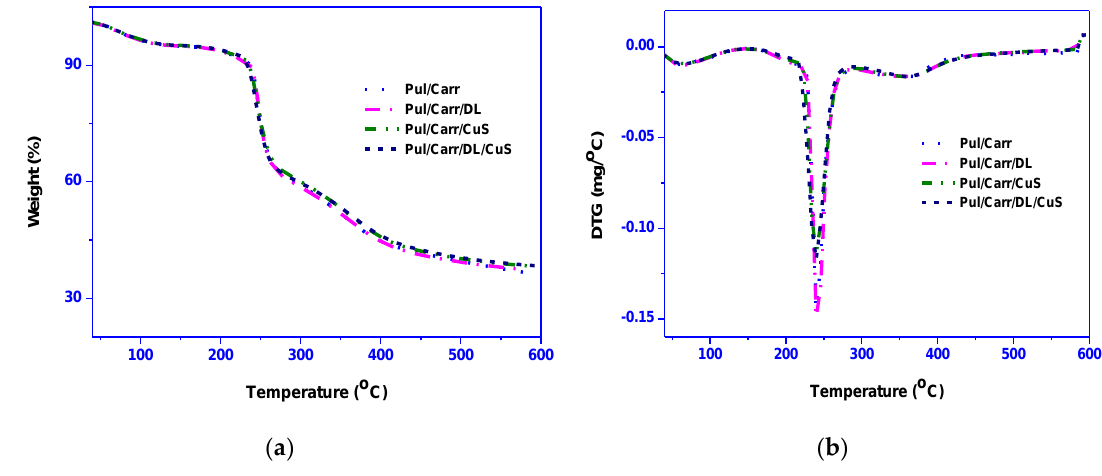
Figure 5. ( a ) TGA and ( b ) DTG thermograms of pullulan/carrageenan-based films. Table 3. Thermogravimetric data of pullulan/carrageenan-based films.